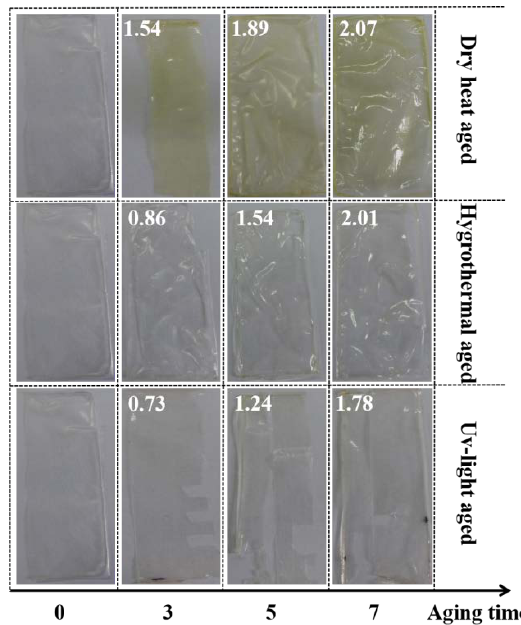
Figure 2. Effect pictures of PVA-217 films before and after aging several days by using three aging methods. The chromatic aberration data (white numbers) were listed in the effect pictures.